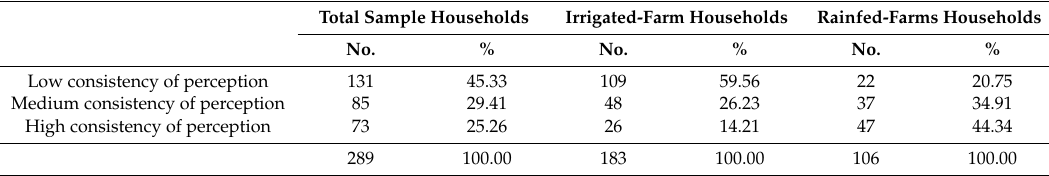
Table 5. Farmer’s perception level to local climate variability. Total Sample Households Irrigated-Farm Households Rainfed-Farms Households No. %